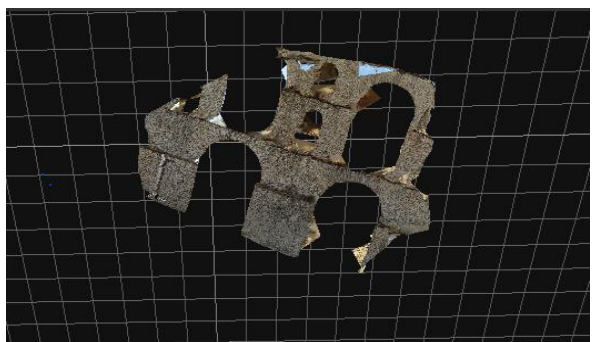
Figure 11 . Zooming the Part of